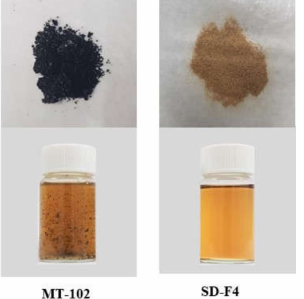
Figure 6. Images of MT-102 (pure extract) and SD-F4. Each formulation equivalent to 25 mg/mL of MT-102 was dissolved in